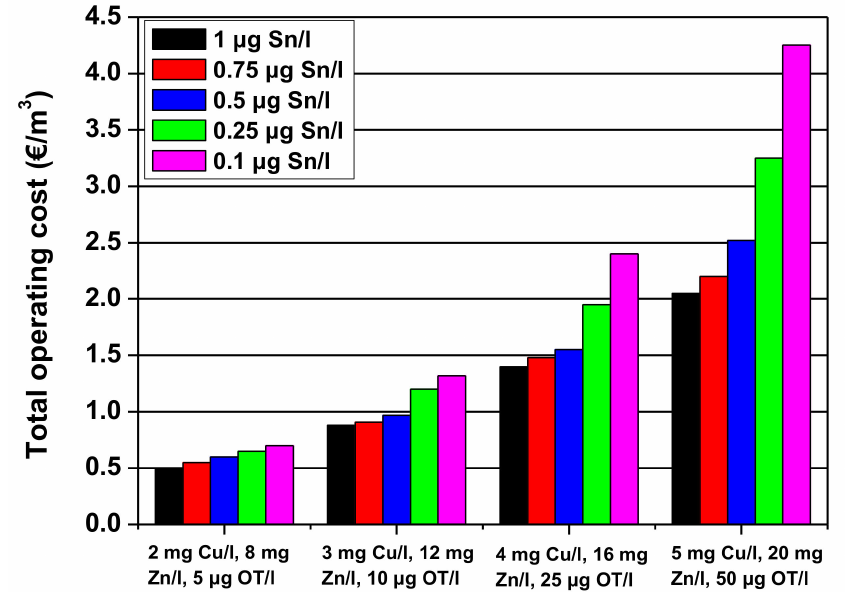
Figure 17. Total operating costs for 4 di ff erent wastewaters for 5 di ff erent organotin discharge limits. Reprinted with permission; Copyright Elsevier, 2008